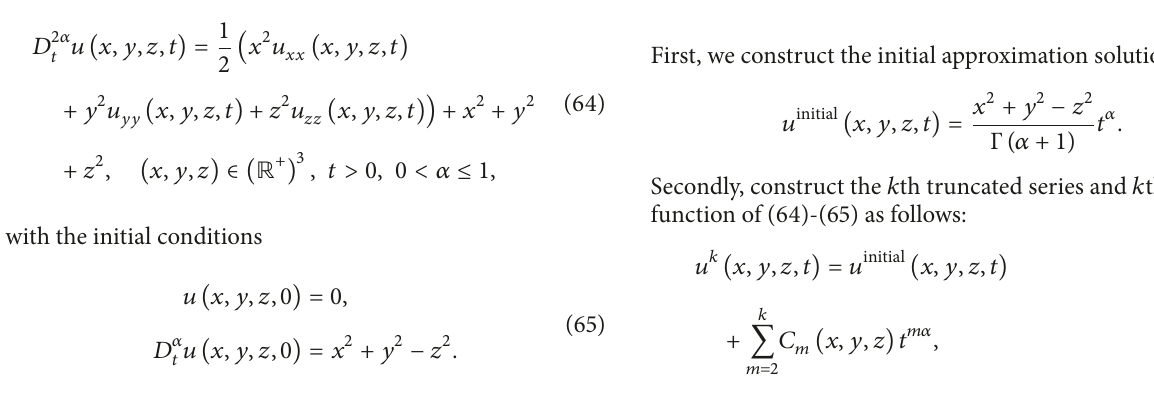
Figure 8: The approximate solutions 𝑢 9 , 𝑢 10 , 𝑢 11 , and 𝑢 12 of (49) at 𝑡 = 5 with 𝛼 = 1